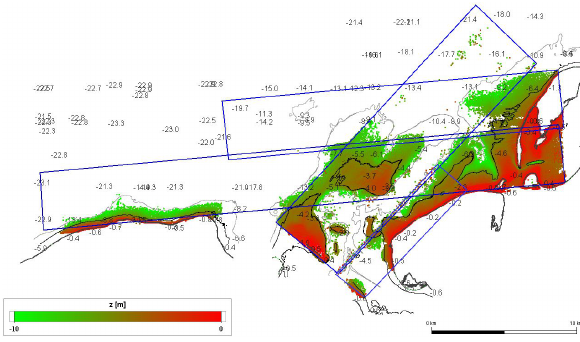
Figure 6: Sea bed points and test areas. Red is 0 mand green is 10m depth. Additionally the coast line, the depth at 5 and at 10m are